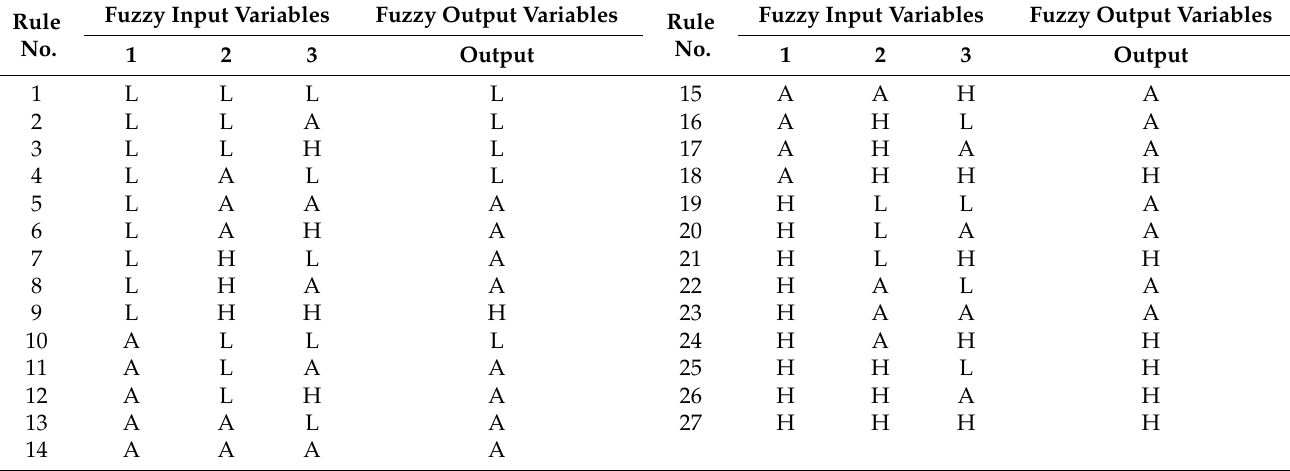
Table 4. Fuzzy IF-THEN β rules.